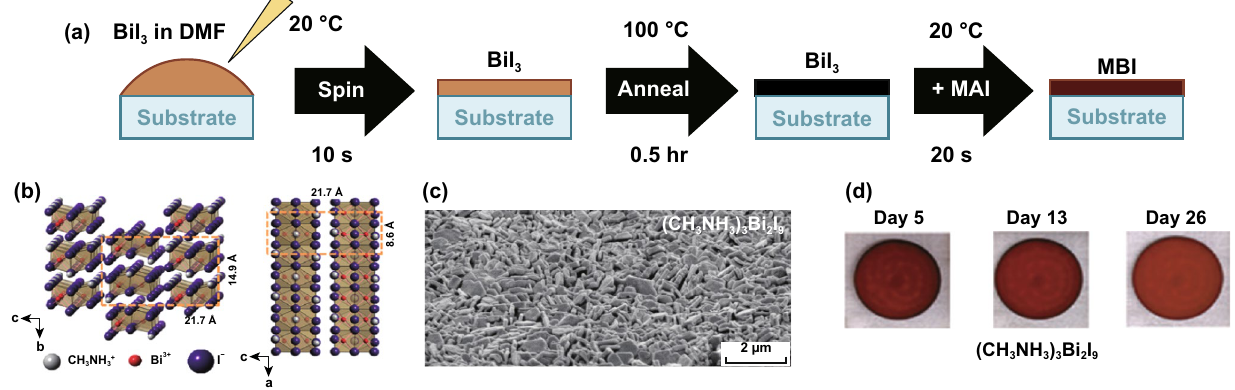
Fig. 12 a Schematic diagram of (CH 3 NH 3 ) 3 Bi 2 I 9 solution-assisted process. b Crystal structure and (001) view of (CH 3 NH 3 ) 3 Bi 2 I 9 . c SEM image of (CH